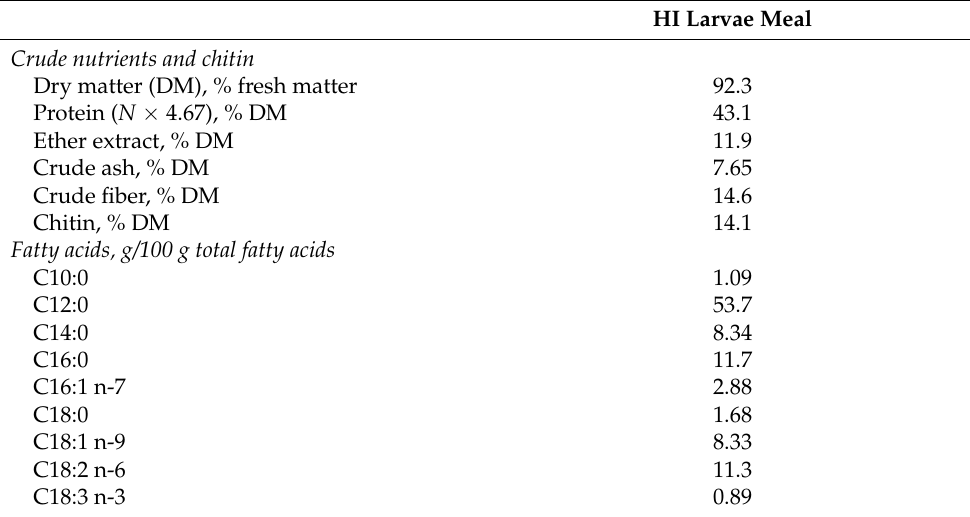
Table 2. Analyzed concentrations of crude nutrients, chitin and fatty acids of the HI larvae